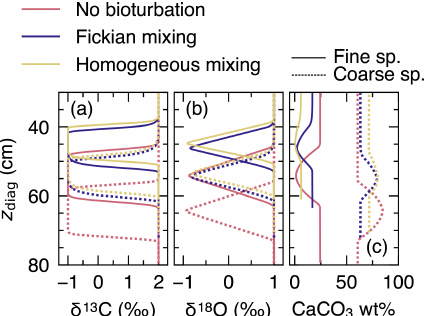
Figure 15. Proxy signals (a, b) and the weight fraction of bulk CaCO 3 in solid sediment (c) for fine and coarse CaCO 3 species (solid and dotted curves, respectively) tracked by eight classes of CaCO 3 particles in simulations examining the effect of species- specific mixing/dissolution